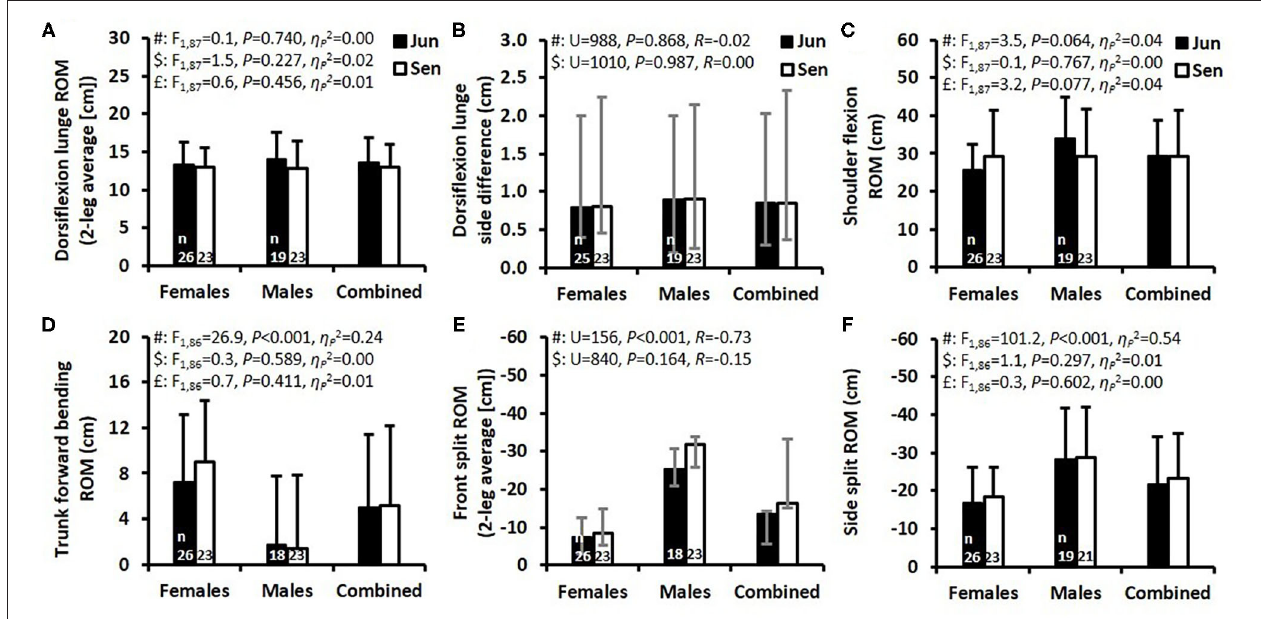
FIGURE 3 | Flexibility test results presented as mean ± standard deviation (SD) (A,C,D,F) and as median and interquartile range (B,E) for the junior (Jun) and senior (Sen) female and male athletes and the combined group of female and male athletes. Abbreviations: ROM, range of motion; Hg, Hedges’ g effect size. F -values, P -values, and partial eta squared effect size ( η 2 p ), were obtained by a two-way ANOVA. #Main effect of sex. $Main effect of age group. £Main effect for interaction between sex and age group. In (B,E) , P -values were obtained by a Mann-Whitney U-test presented together with an R effect size. The numbers located at the bottom of each of the four bars indicate the number of participants ( n ) in the specific